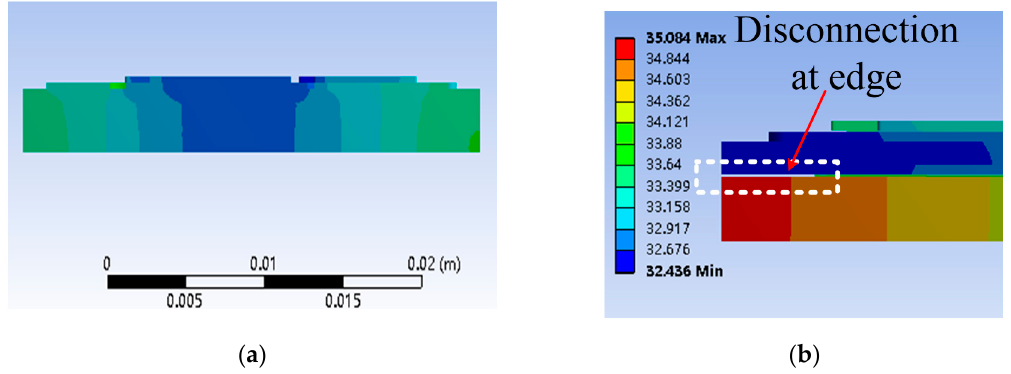
Figure 9. Temperature map of cross-sectional IGBT module based on simulation: ( a ) 100% connection and ( b ) 70% connection area.